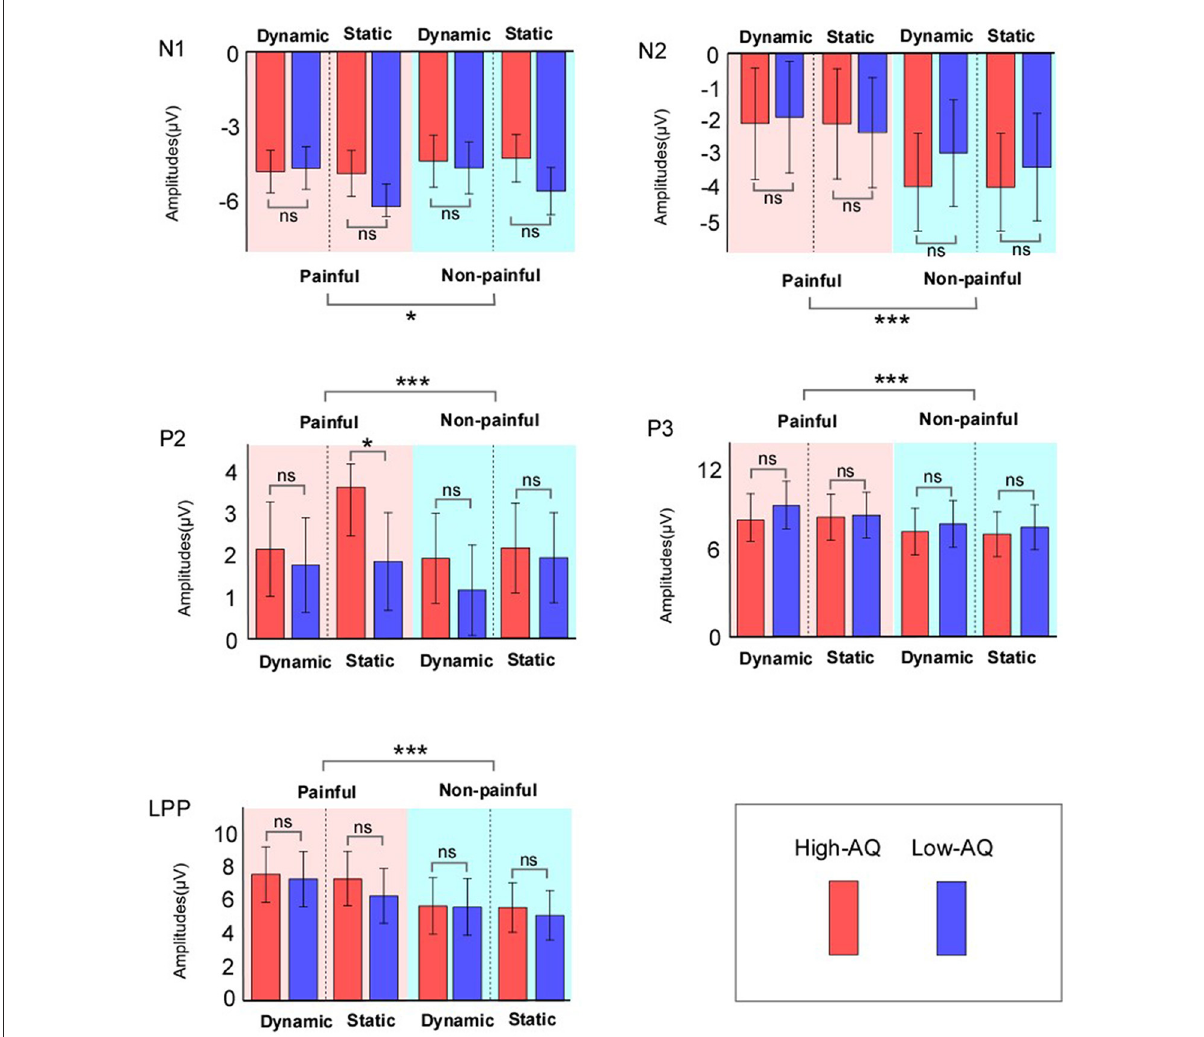
FIGURE4 ERP amplitudes of High-AQ (blue bar) and Low-AQ (red bar) groups in response to static and dynamic stimuli. Data in the charts are expressed as Mean ± 2SEM. ns: p > 0.05, * p < 0.05, ** p < 0.01, *** p < 0.001.